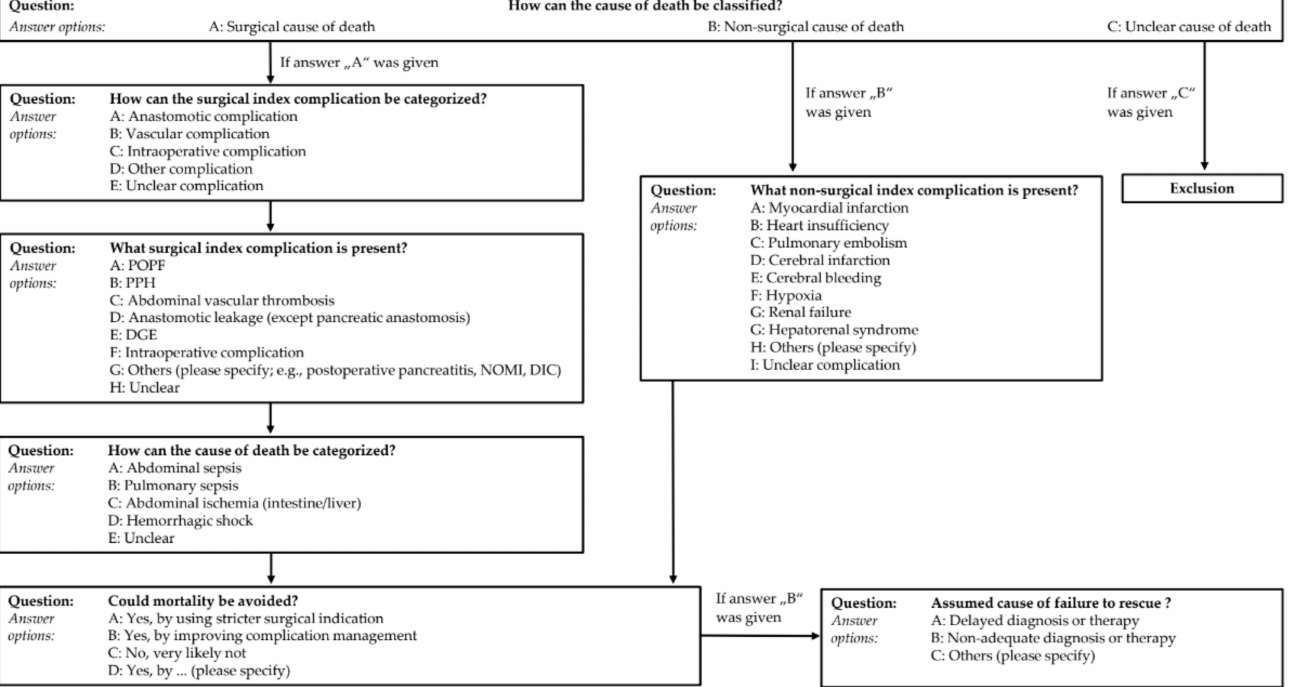
Figure 3. Standardized questionnaire for clinical peer reviews of patient cases with perioperative mortality in pancreatic surgery. POPF = post-operative pancreatic fistula, PPH = post-pancreatectomy hemorrhage, DGE = delayed gastric emptying, NOMI = non-occlusive mesenteric ischemia, DIC = disseminated intravascular